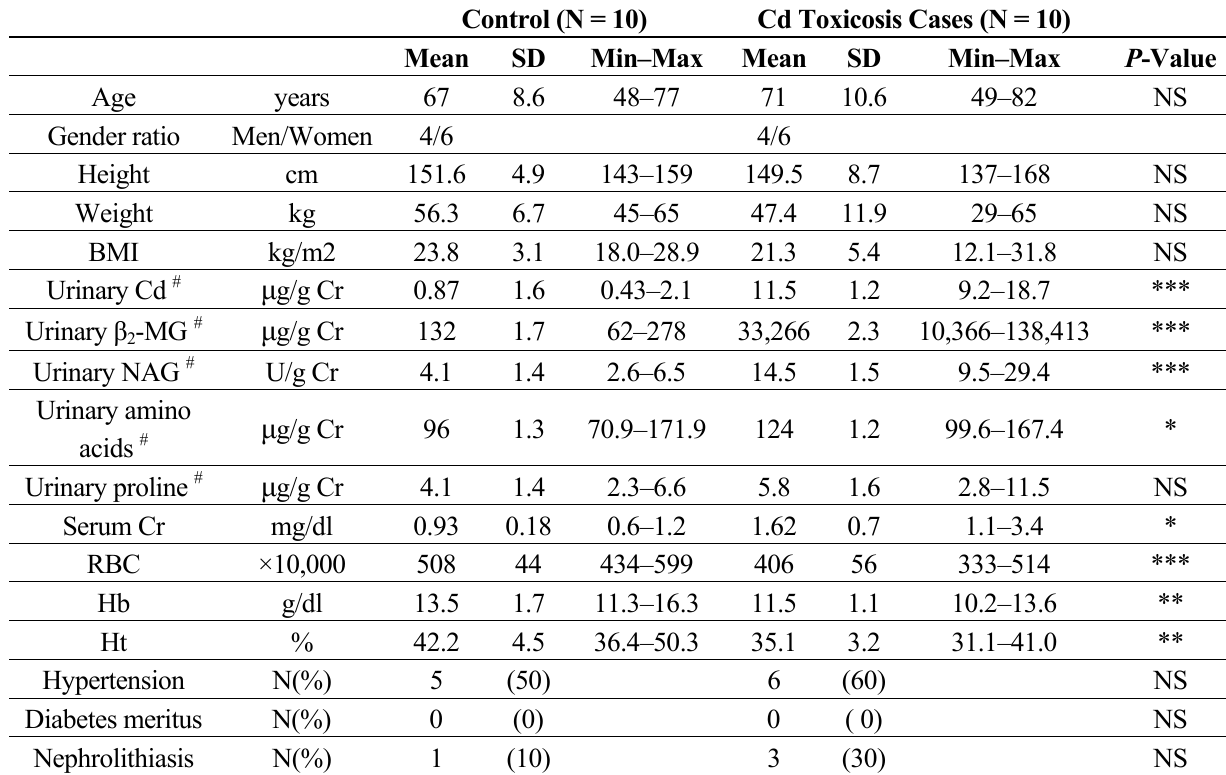
Table 1. Clinical characteristics of cadmium toxicosis cases and controls in a non-polluted